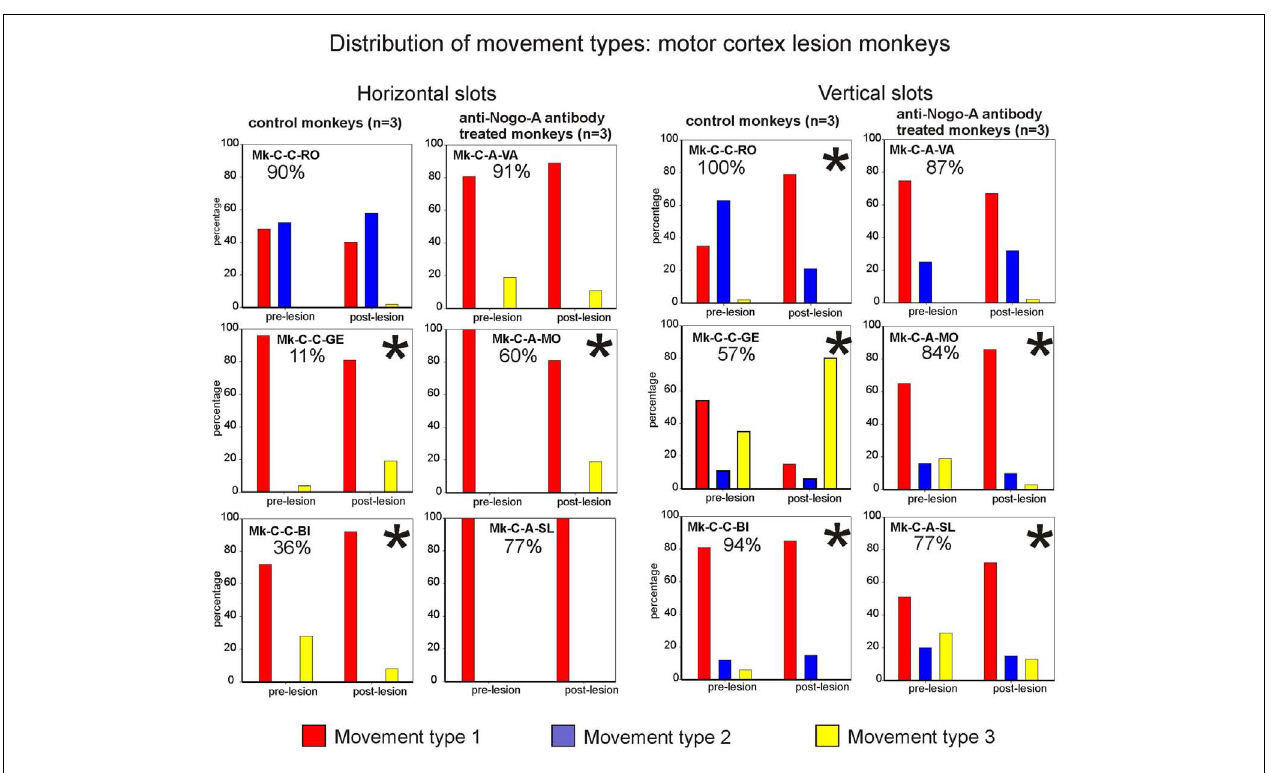
FIGURE 7 | Distribution of movement types observed for grasping pellets from the horizontal slots (left column) or from the vertical slots (right column) for the six monkeys subjected to motor cortex